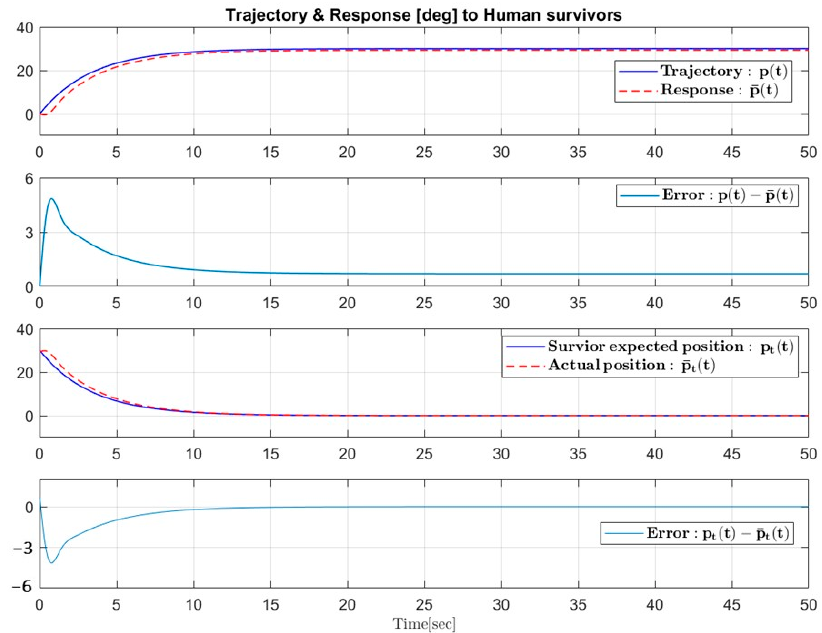
Figure 15. Experiential results of Case I: target trajectory vs. resulting trajectory and target orientation vs. resulting orientation.